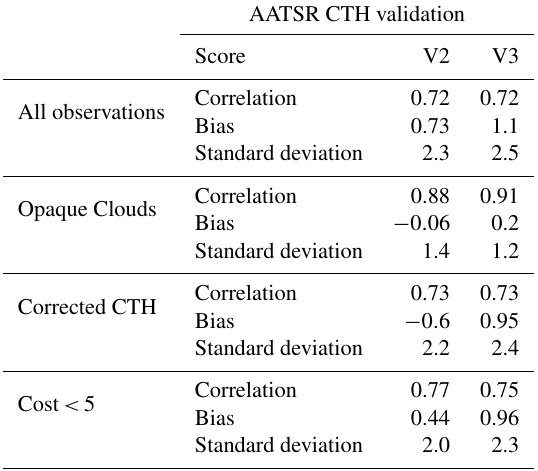
Table 4. Comparison of AATSR cloud top height with co-located CALIPSO measurements for 5d in 2008. On the left V2 is shown, and V3 is shown on the right . The results are shown for all observa- tions, only opaque clouds (as defined by CALIPSO), the corrected cloud top height product and retrievals with a cost of less than 5. All values are in kilometres.